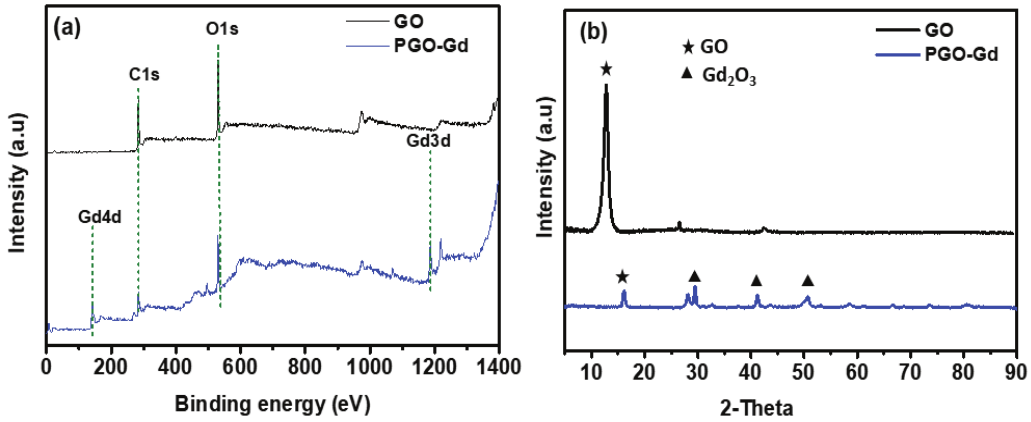
Figure 2. ( a ) XPS and ( b ) XRD of GO and PGO–Gd.